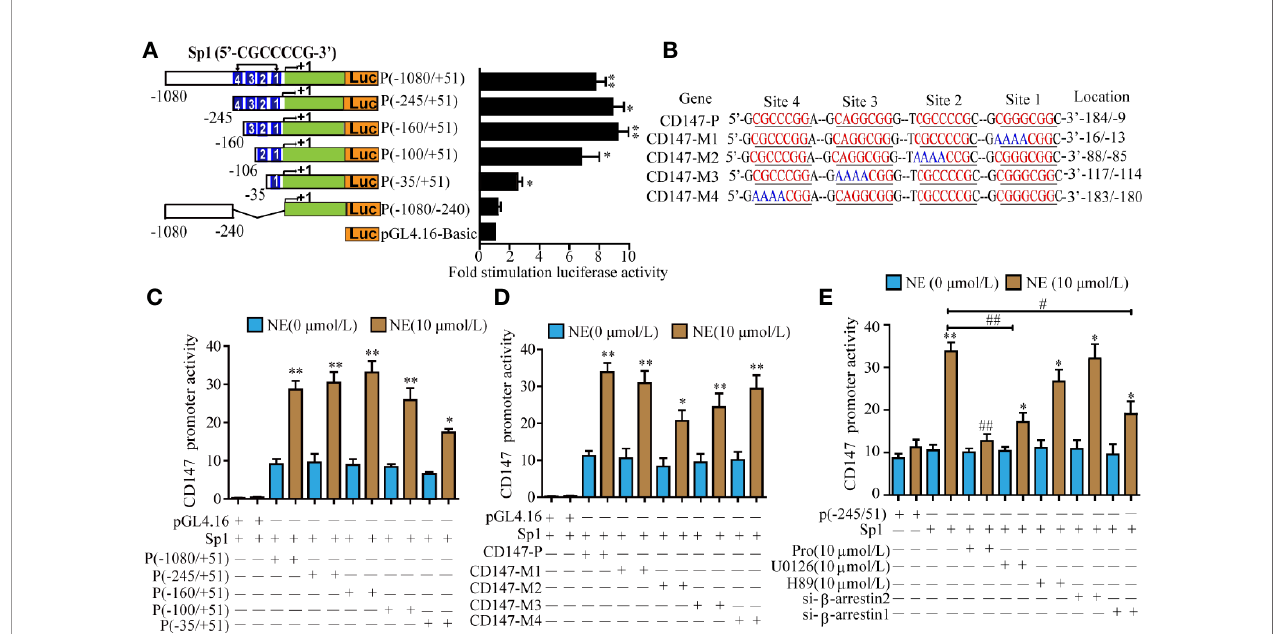
FIGURE 5 | The Transcription Factor Sp1 Mediated the norepinephrine (NE)-Induced High Expression of CD147. (A) Schematic diagram of luciferase assay for different lengths of CD147 promoter activity, *P<0.05, **p<0.01 compared with the empty PGL4.16 vector. (B) Luciferase activity of different truncated human CD147 promoters after stimulation with 10 m mol/L NE. (C) Schematic diagram of the mutation in the node of Sp1 in the CD147 promoter. (D) Detection of 10 m mol/ L NE-induced luciferase activity of CD147-P, CD147-M1, CD147-M2, CD147-M3, and CD147-M4 co-transfected with Sp1. (E) The effect of the b -adrenergic receptor inhibitor propranolol (10 m mol/L), the PKA inhibitor H89 (10 m mol/L), the ERK inhibitor U0126 (10 m mol/L), si- b -arrestin1, and si- b -arrestin2 on Sp1- mediated CD147-P (-245/+51) luciferase activity. Luciferase activity was normalized to that of renilla luciferase, *P < 0.05, **P < 0.01, compared with 0 m mol/L NE; # P < 0.05, ## P < 0.01 compared with Sp1-CD147-P (-245/+51)+10 m mol/L